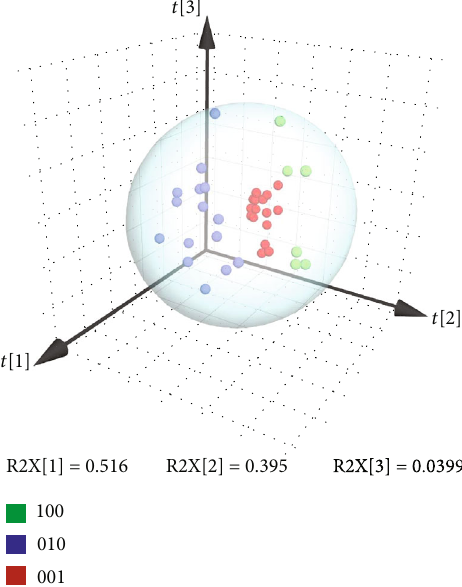
Figure 8: Schematic diagram of the PLS-DA model in three- dimensional space. 100: fourth aquifer water; 010: coal-bearing sandstone aquifer water; 001: limestone aquifer water.